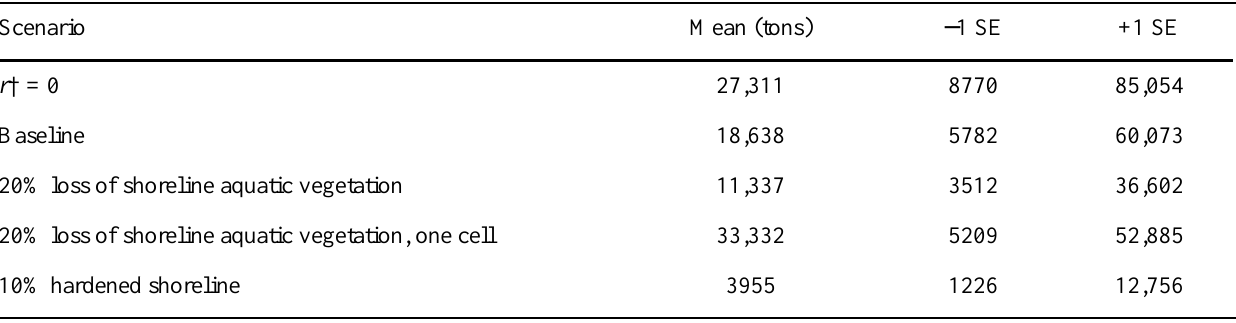
Table 5. Summary statistics for modeled scenarios of the effects of habitat change on Gulf of Mexico blue crab landings. Means are for the last five years of simulations, with 1000 iterations/yr ( N = 5000). Statistics are back-transformed from approximately log-normal distributions, i.e., geometric means and errors. SE = bootstrap standard error of the